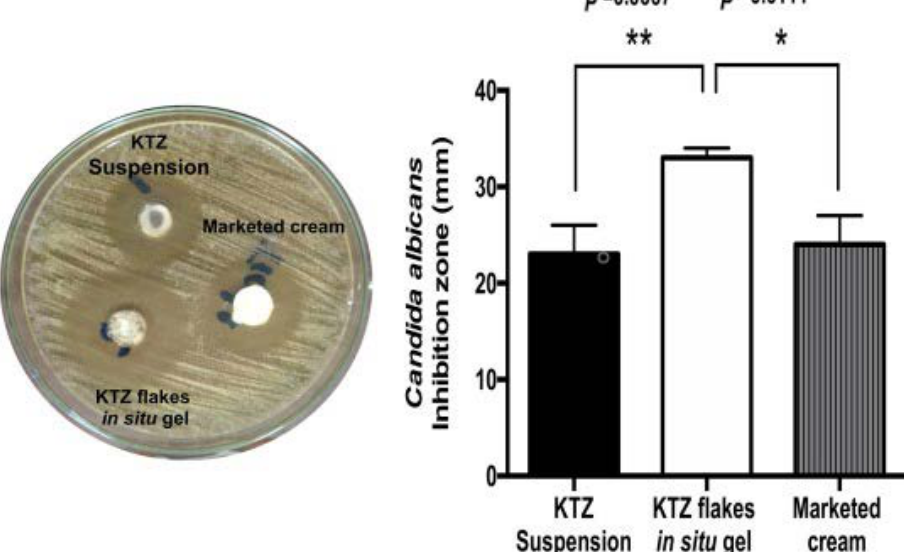
Figure 9. Zone of inhibition (mm) for ketoconazole suspension, marketed vaginal cream (terconazole) and ketoconazole flakes-loaded in situ gel. Adapted from “Efficacy of ketoconazole gel-flakes in treat- ment of vaginal candidiasis: formulation, in vitro and clinical evaluation” by Abd Ellah et al.